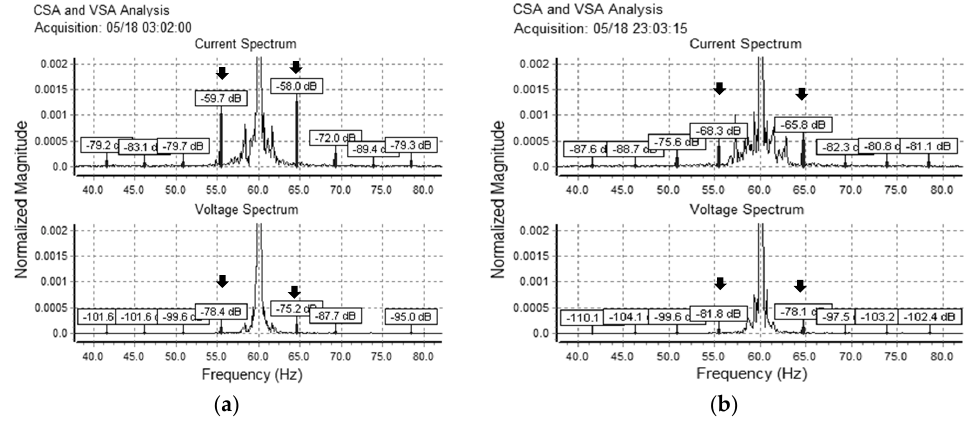
Figure 8. Rotation frequency of the current and voltage signatures of Goiandira GUs: ( a ) GU#1; ( b ) GU#2.